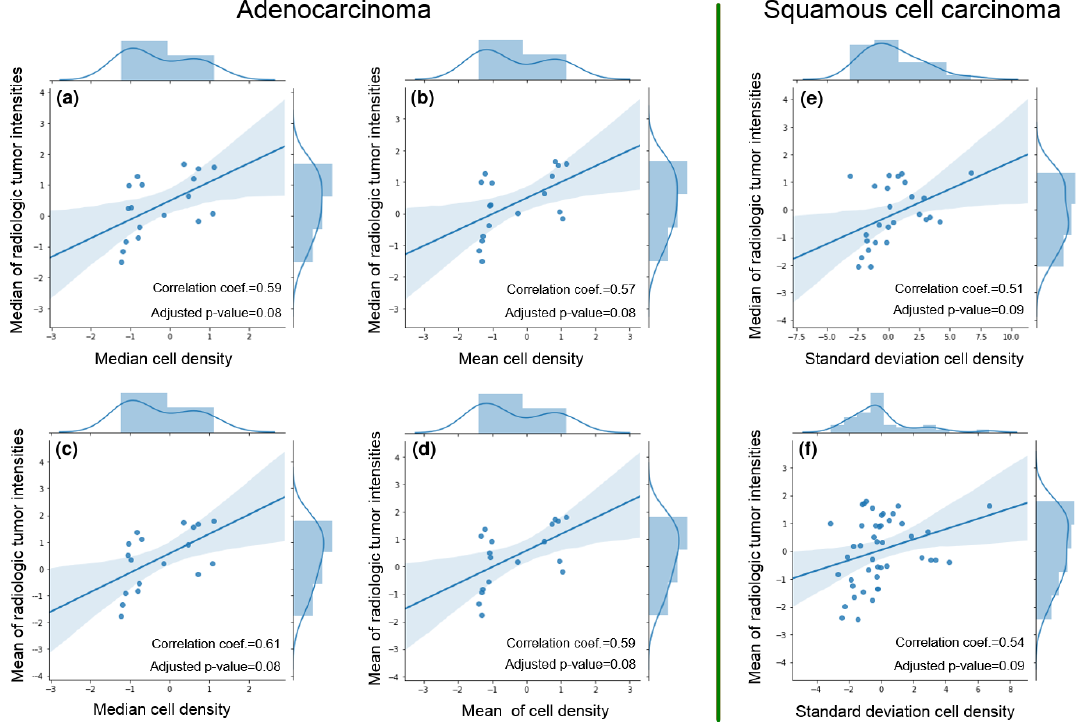
Figure 8. Scatter plots of six pairs of correlated features identified via pathomic-radiomic association for ( a – d ) ADC stuides, and ( e , f ) SCC studies. Also noted are correlated coefficients as well as FDR-adjusted p -values. The histogram of pathomic feature are plotted along the X-axes of each plot, while radiomic features are plotted along